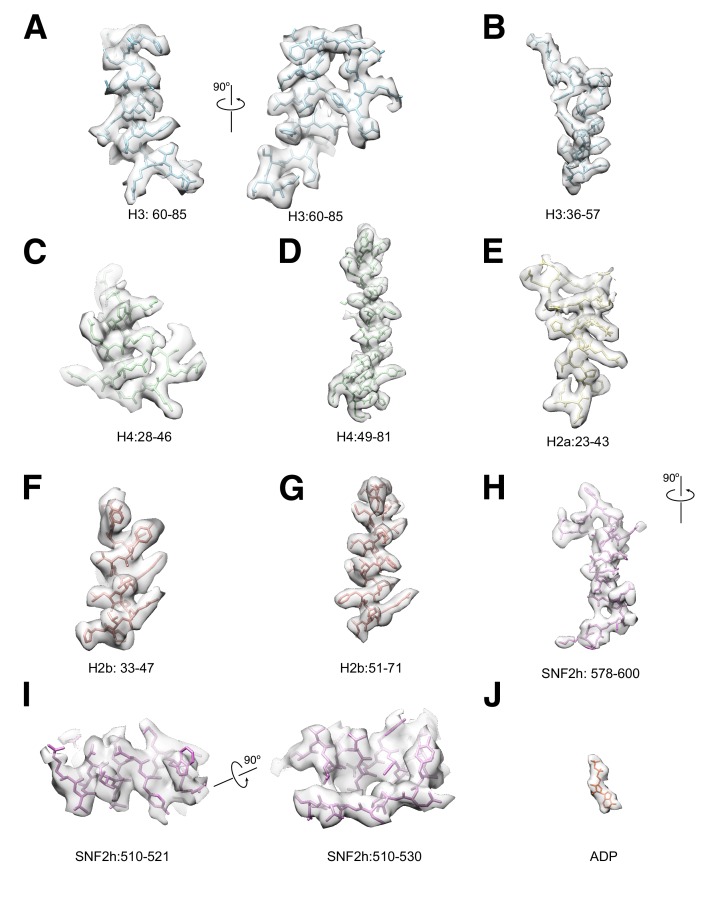
Selected Cryo-EM protein densities.Representative 3.4 Å resolution cryo-EM densities of SNF2h and core histones superimposed on the atomic model. The density maps are shown as semi-transparent, and the model is colored according to the color scheme in the main figures ((A–B) H3: blue, (C–D) H4: green, (E) H2a: yellow, (F–G) H2b: red, (H–I) SNF2h: purple, (J) ADP: orange).